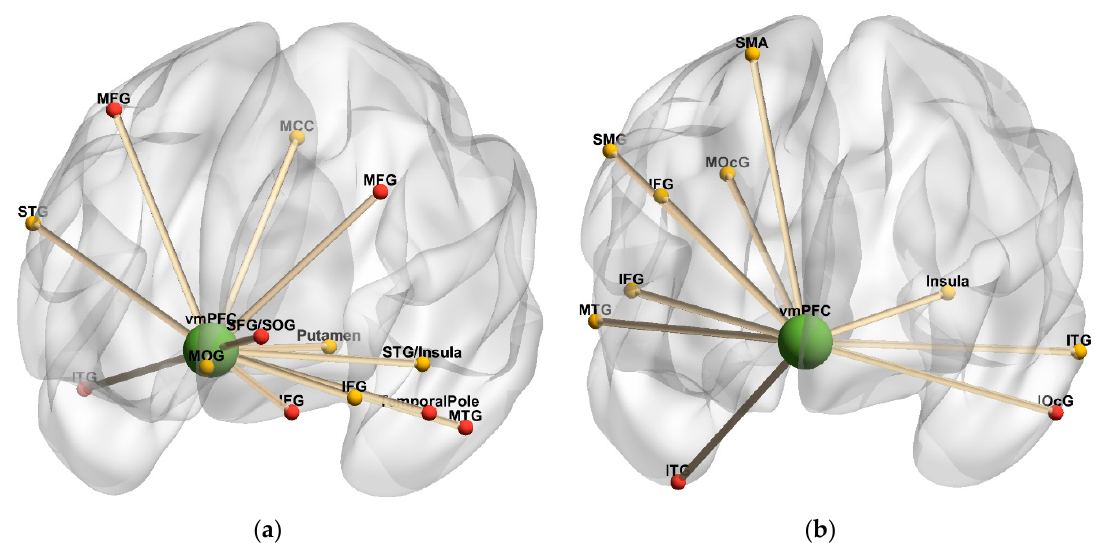
Figure 5. Ventromedial prefrontal cortex connectivity 3-dimensional rendering. ( a ) Task-independent, fatigue-related connectivity in the healthy control group. ( b ) Task-independent, fatigue-related connectivity in the multiple sclerosis group. The seed is denoted by green spheres; regions with increased connectivity to the seed in the 2-back condition are denoted by yellow spheres, and regions with increased connectivity to the seed in the 0-back condition are denoted by red spheres. Cerebellar regions were omitted. Anterior orientation is in the front of the figure; right hemisphere is on the left side, and left hemisphere is on the right side. Abbreviations: SFG, superior frontal gyrus. MFG, middle frontal gyrus. IFG, inferior frontal gyrus. vmPFC, ventromedial prefrontal cortex. MCC, middle cingulate cortex. SMA, supplementary motor area. SOG, superior orbital gyrus. MOG, middle orbital gyrus. SMG, supramarginal gyrus. STG, superior temporal gyrus. MTG, middle temporal gyrus. ITG, inferior temporal gyrus. MOcG, middle occipital gyrus. IOcG, inferior occipital